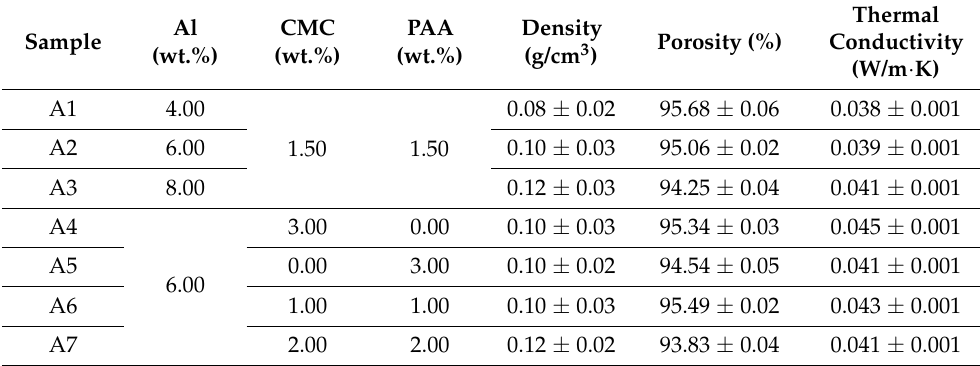
Table 3. Density, porosity, and thermal conductivity of the